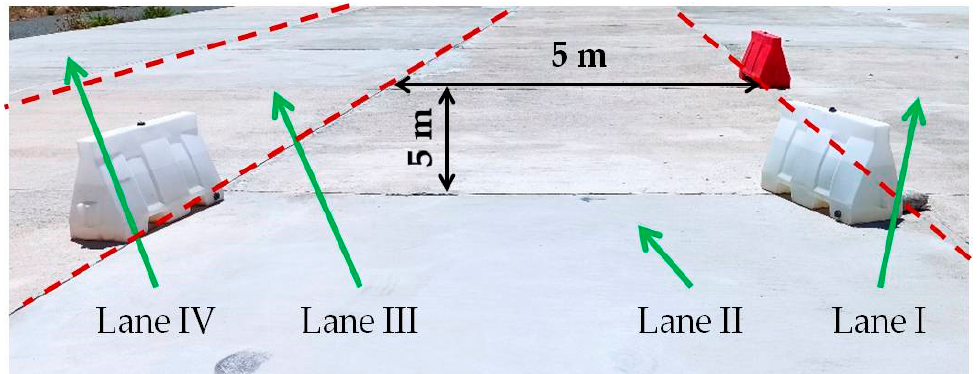
Figure 6. Example of a shrinkage crack.